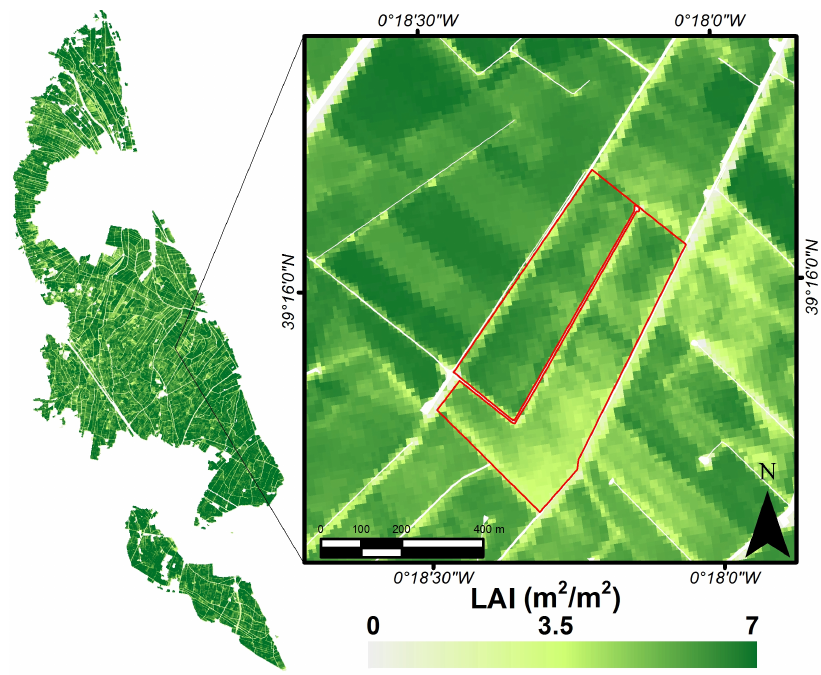
Figure 3. High-resolution LAI map obtained with Sentinel-2A data acquired in the Spanish study area on 9 August 2016. The right panel provides a zoom over a monitored field in the rice